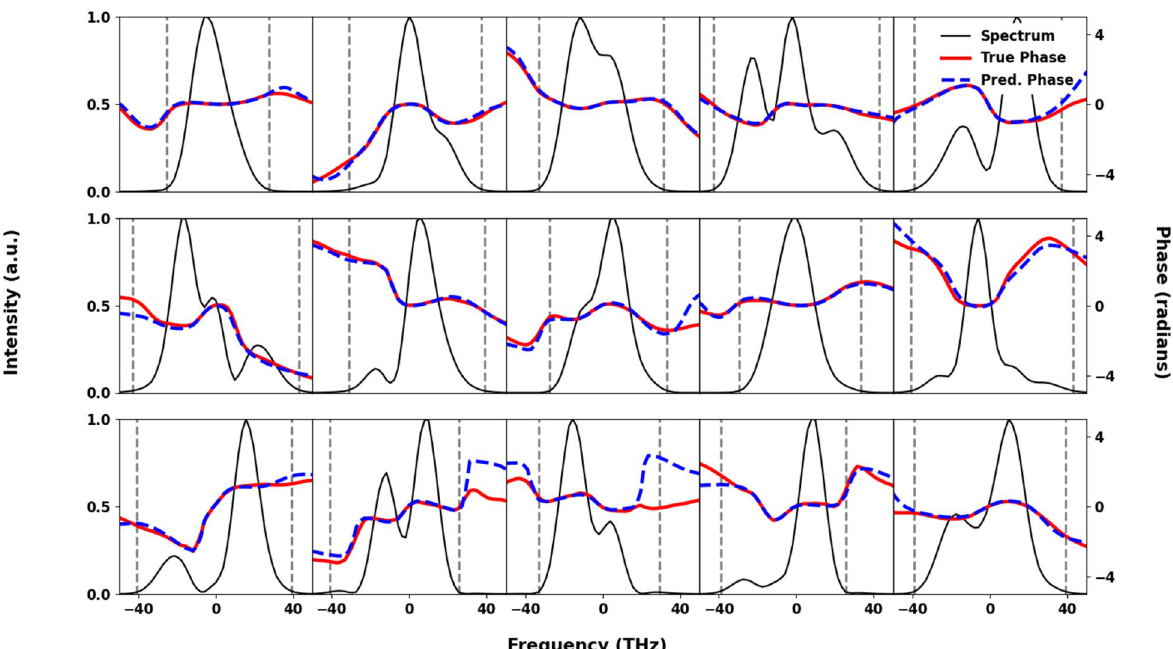
Figure 3. Examples of reconstructed pulses multiple examples of the variety of simulated initial spectra and phases predicted by the simulated few-cycle neural network (dashed blue) and the true phase (red). The predicted phase matches well in all regions of high spectral intensity, with disagreement only occurring in regions of near zero spectral intensity. Vertical dashed lines show location of the dB-20 spectral